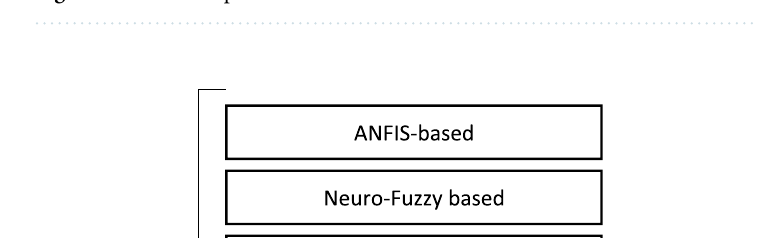
Figure 1. The overlap between intrusion behaviours and normal behaviours.